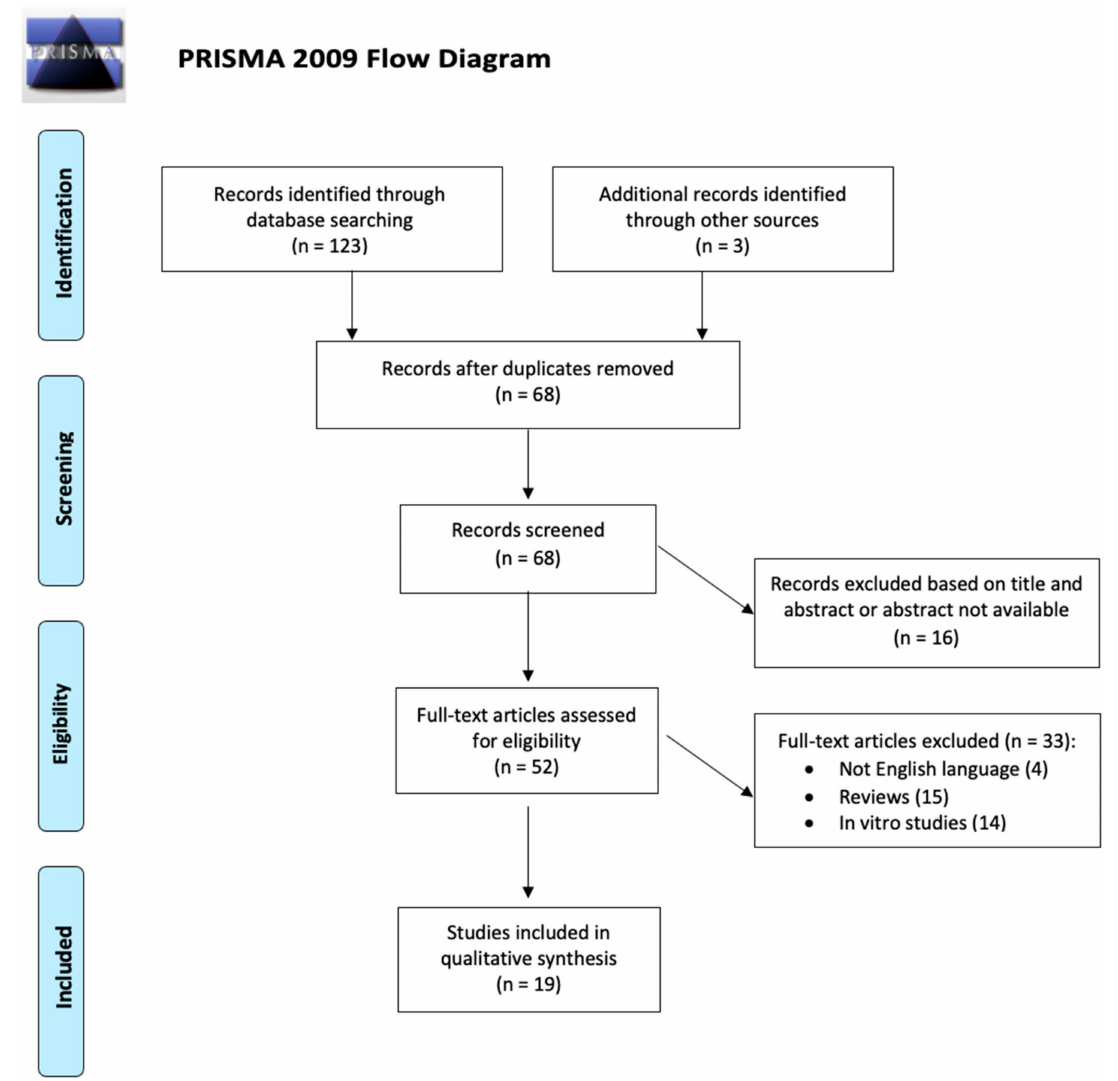
Figure 1. PRISMA